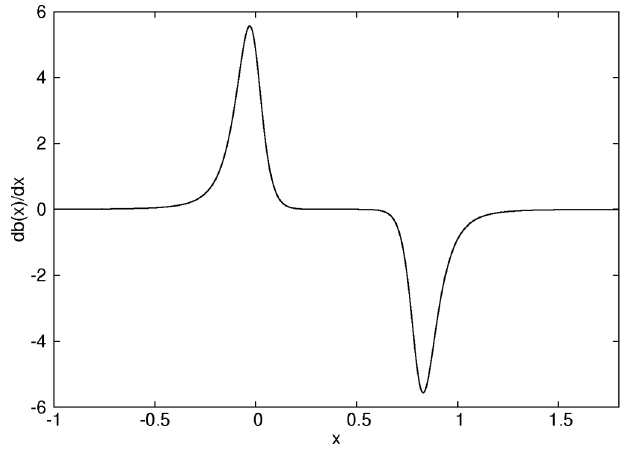
FIG. 4. First derivative of the field profile for a dipole magnet